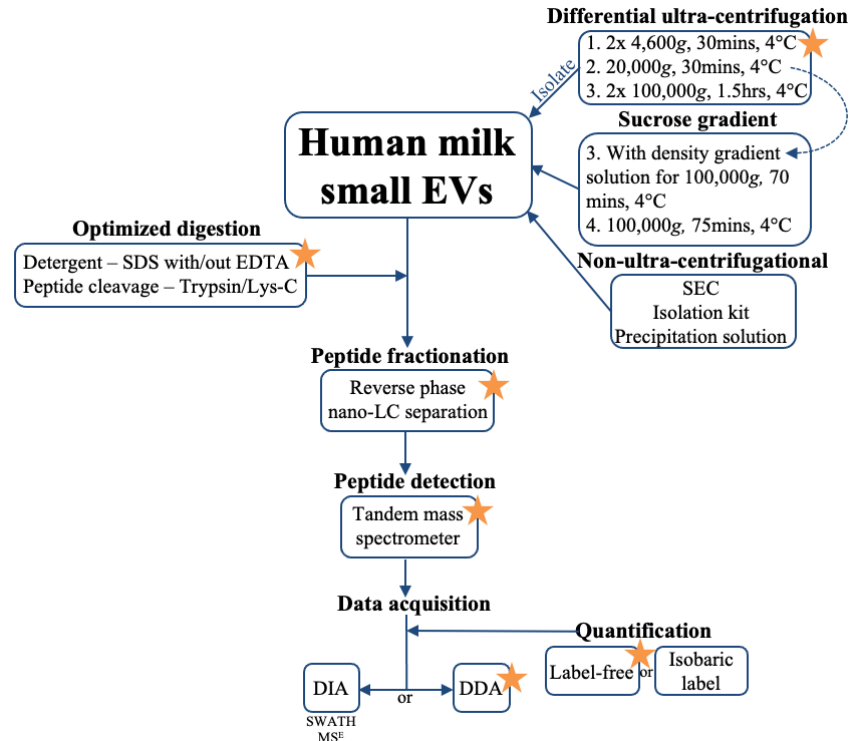
Figure 5. Workflow for human milk small extracellular vesicle (EV) bottom-up proteomics. Human milk small EVs can be isolated using differential centrifugation with or without sucrose gradient, or using non-ultra-centrifugational methods (SEC–size exclusion chromatography). Protein digestion can be achieved using an SDS detergent with or without EDTA, following peptide cleavage with Trypsin/Lys/C, however solubilization agents and trypsinization should be optimized for each experiment depending on analysis end-goals. Chromatographic fractionation of peptides follows, which can include reverse phase nano-liquid chromatography (nano-LC). Peptides are detected by tandem mass spectrometer and data acquired using data independent acquisition (DIA: SWATH-Sequential Windowed Acquisition of All Theoretical Fragment Ion; MS E ), or data dependent acquisition (DDA), which can be coupled with label-free or isobaric labeling of EV sample. Orange star emphasizes suggested method for use in human milk EV proteomics, as identified in prior publications on human milk EV proteomic